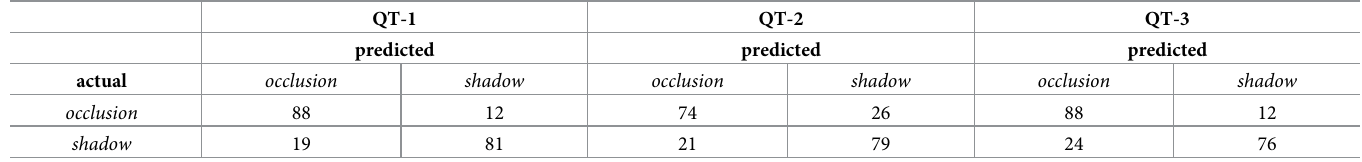
Table 1. AO confusion matrix for all QT